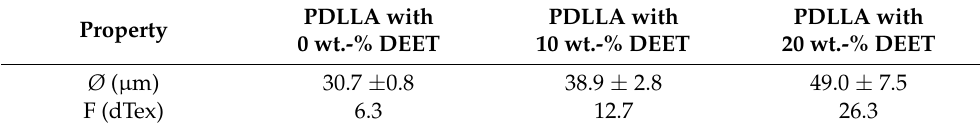
Table 4. Dimensions of the PDLLA monofilaments with varying DEET mass fractions.